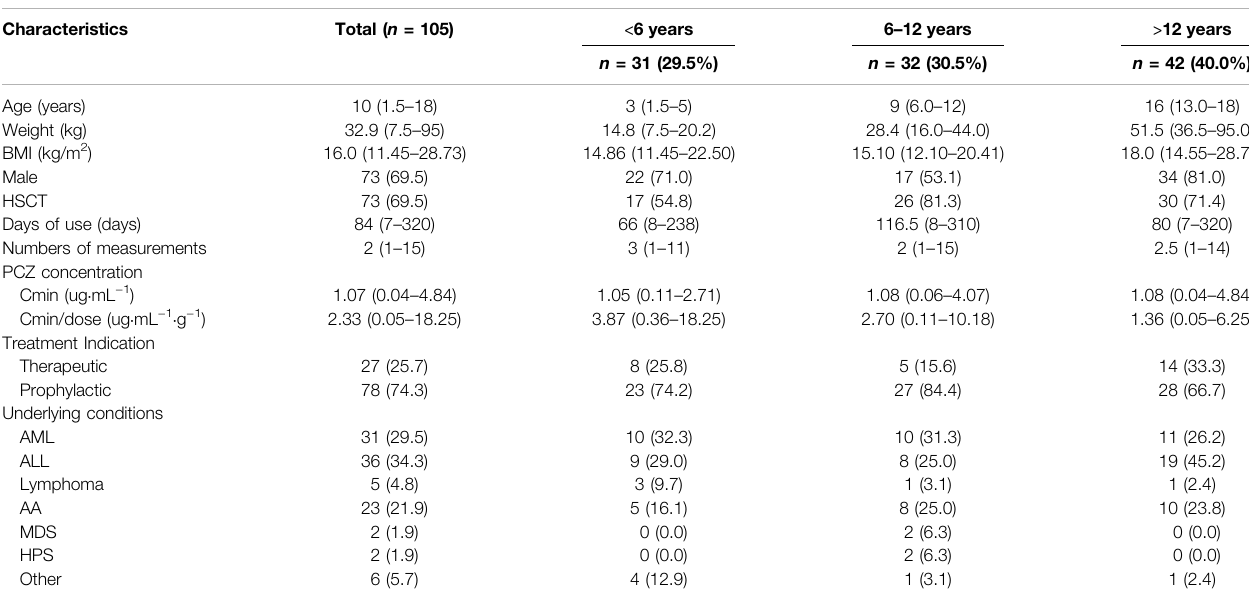
TABLE 1 | Patient